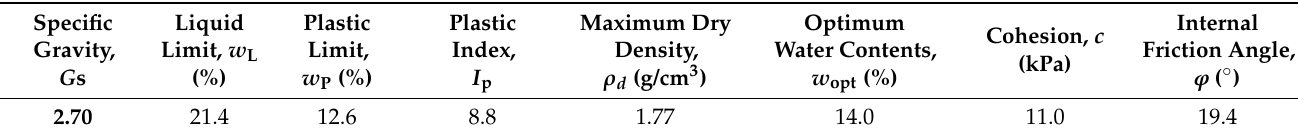
Figure 1. Grain size distribution curve of soil samples. Table 1. The physical mechanics of the soil samples.